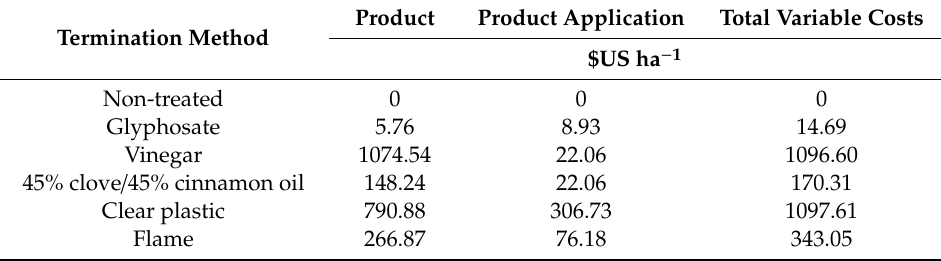
Figure 2. The 2014 and 2015 average daily temperature (°C), solar radiation (Wh/m 2 ), and precipitation (mm). Table 1. Total variable costs by termination method ($US ha −1 ).